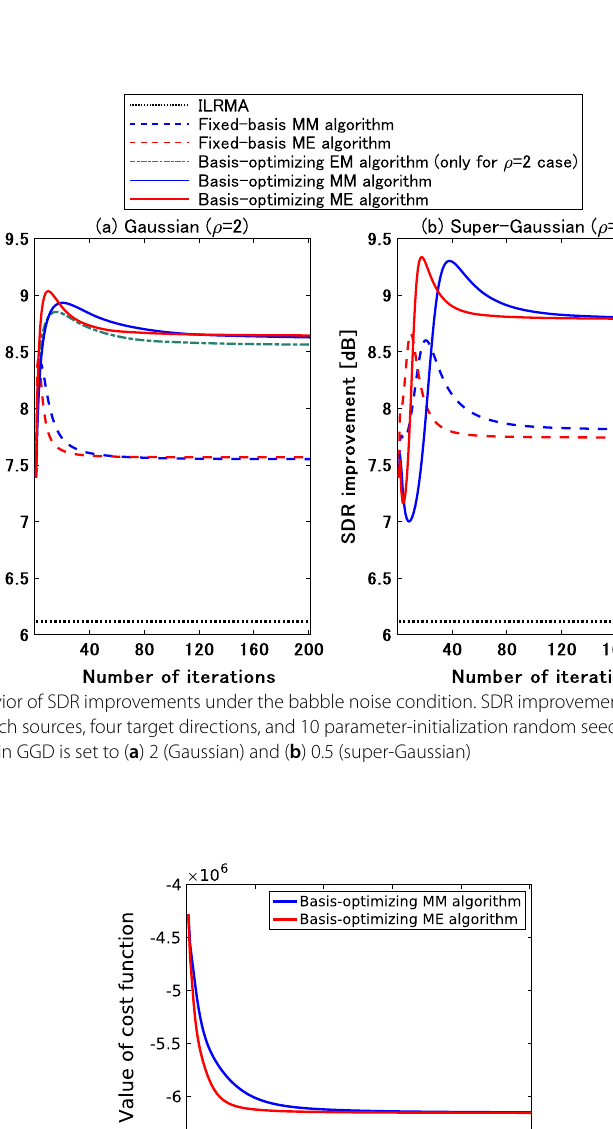
complexity than (35), the computational times of the proposed MM- and ME-algorithm- based basis-optimizing RCSCMEs are expected to be almost the same. In fact, according to the experiment, the averages of the execution times per step in MM- and ME-algo- random seeds and 200 iterations, were 10.3 s and 10.2 s, respectively. This time measure - ment was executed under the condition that the target speech originated from the loud- speaker located 0 ◦ clockwise from the normal to the microphone array and the shape parameter ρ was set to 2. The code for the time measurement was implemented in MAT- LAB (R2022a), and the computation was performed on an Intel Core i9-9980XE (3.00